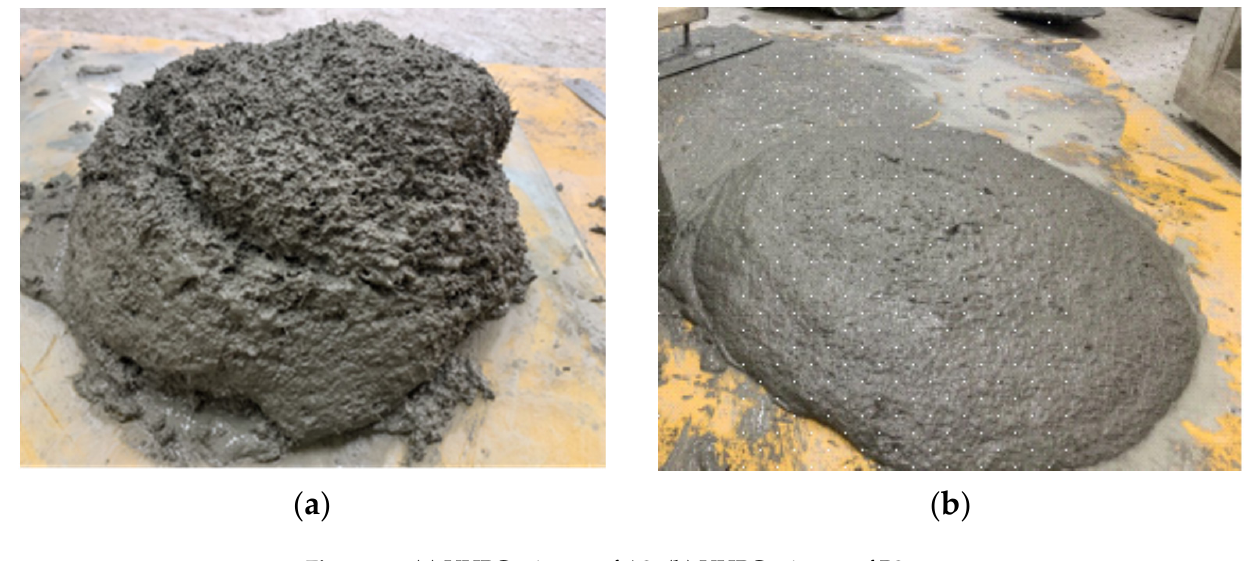
Figure 10. ( a ) UHPC mixture of A2. ( b ) UHPC mixture of B2.